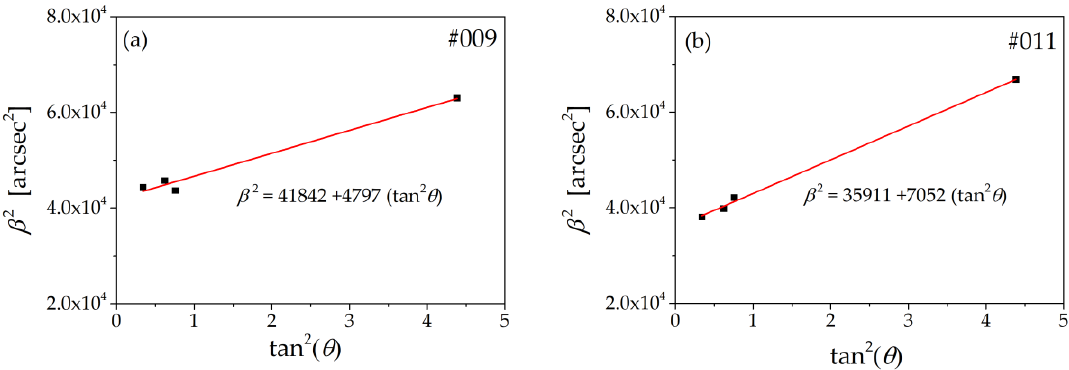
Figure 1. Linear dependence of β 2 vs tan 2 ( θ ) for metamorphic #009 ( a ) and interfacial misfit array (IMF) #011 ( b ) GaSb materials.